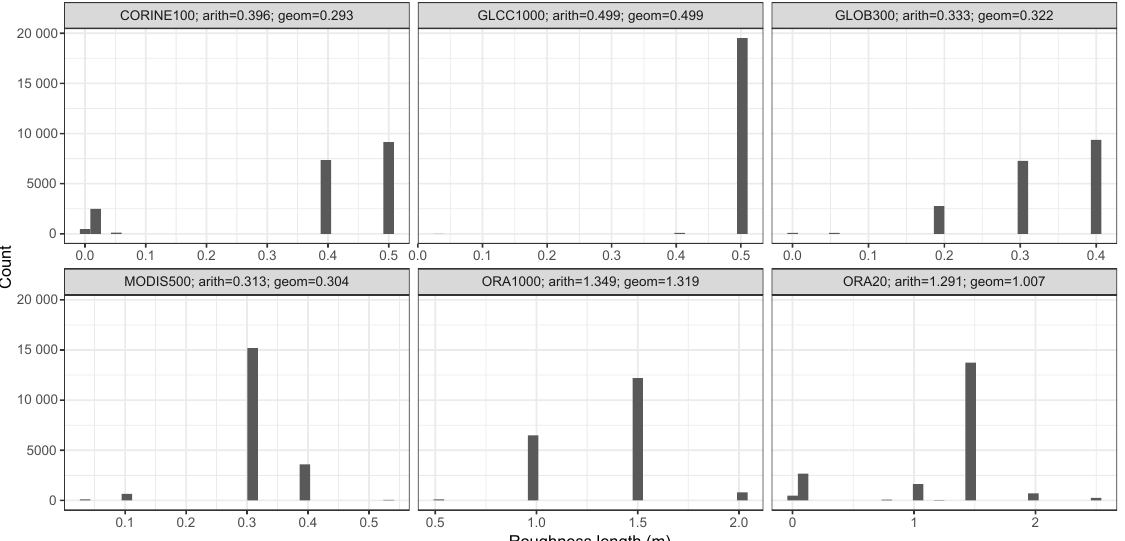
Figure 3. Histogram of roughness for different datasets over the same domain as shown in Fig. 2. The header of each graph also contains the arithmetic and geometric means of roughness for the region.